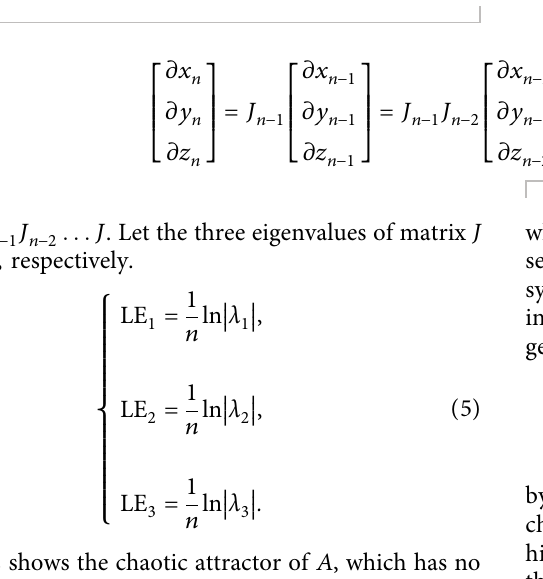
,c ) ∈ [ 0 , 15 ] × [ 0 , 15 ] ; (b) an enlargement of and c . (a) ( c 1 2 1 2